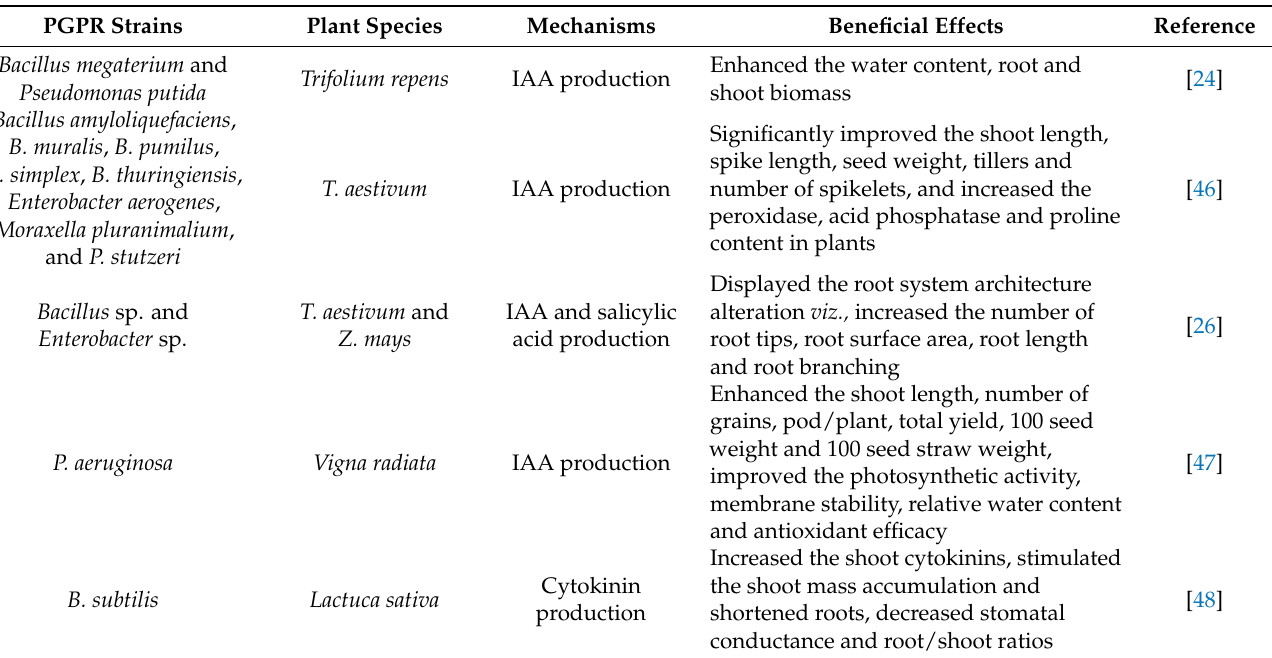
Figure 2. PGPR-mediated modulation of phytohormones for enhancing drought tolerance in plants. Table 1. PGPR-mediated production of phytohormones in enhancing plant drought stress tolerance.